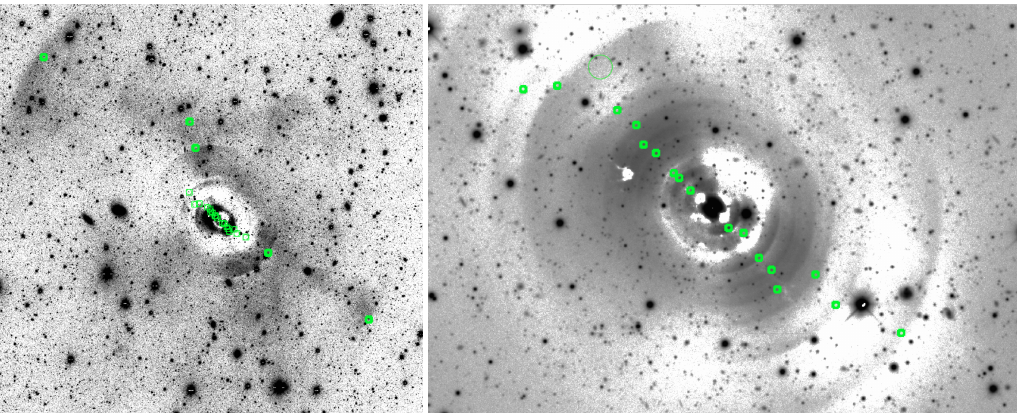
Figure 5. The green squares mark the rims of the clear, strong shells identified in NGC 3923. The underlying background galaxy light has been removed by fitting a two-Sersic model with Imfit [23]. The left panel shows the full shell system and the right panel is an expanded view of the inner region.